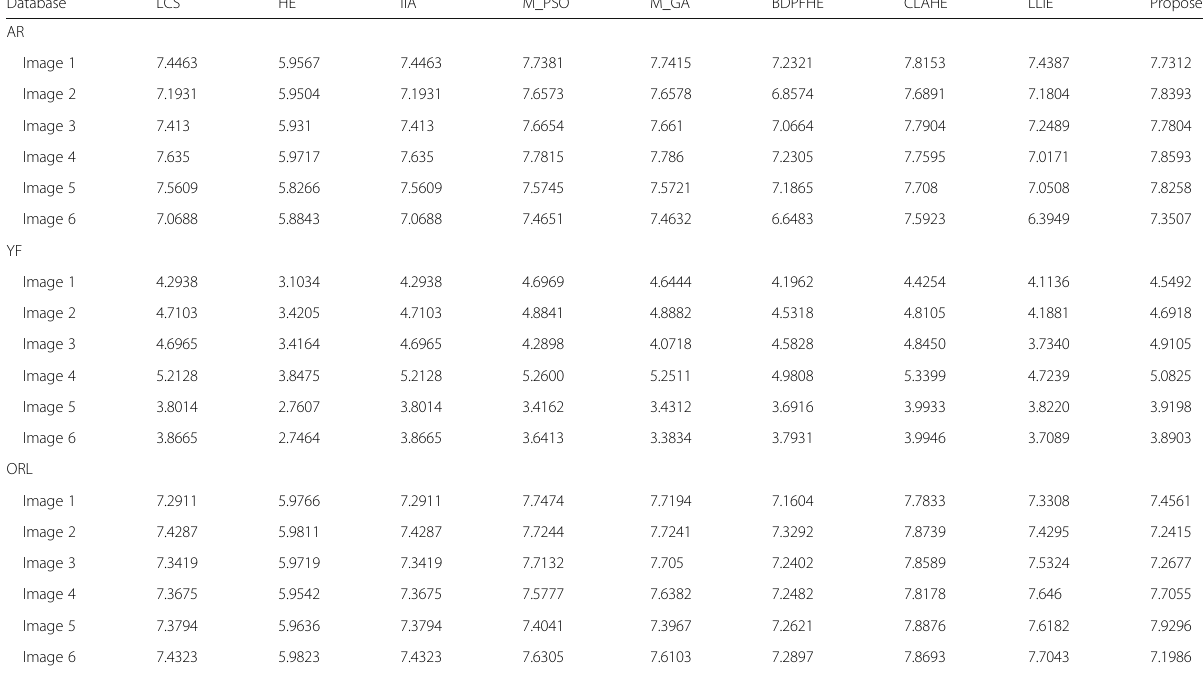
Table 7 Entropic measure value comparison between results obtained using different enhancement methods on standard benchmark face